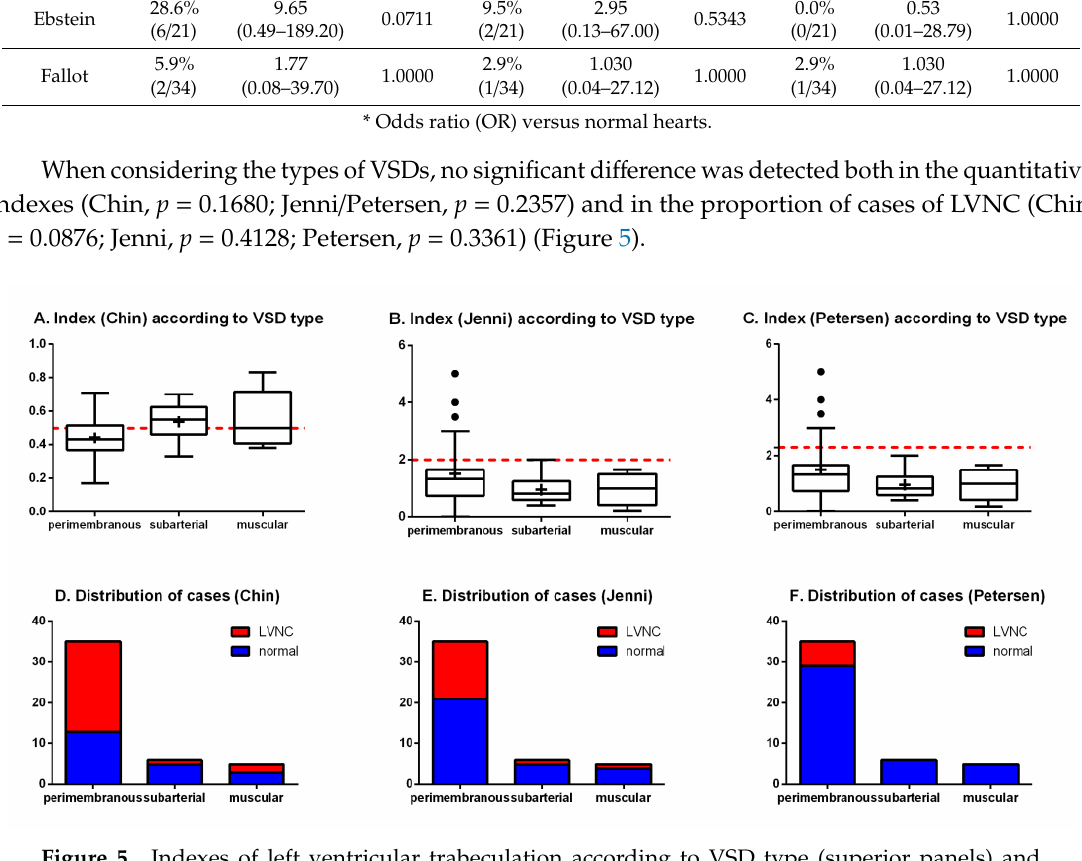
Table 4. Percentage of hearts presenting LVNC according to Chin, Jenni, and Petersen (apex). Chin